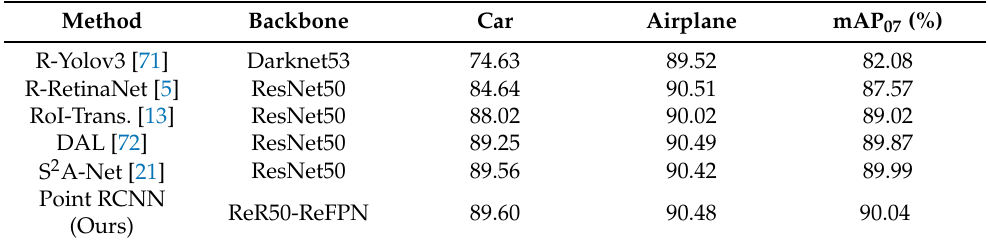
Table 5. Performance comparisons for the UCAS-AOD test set (AP (%) for each category and overall mAP (%)). All models were evaluated via the VOC2007 metric